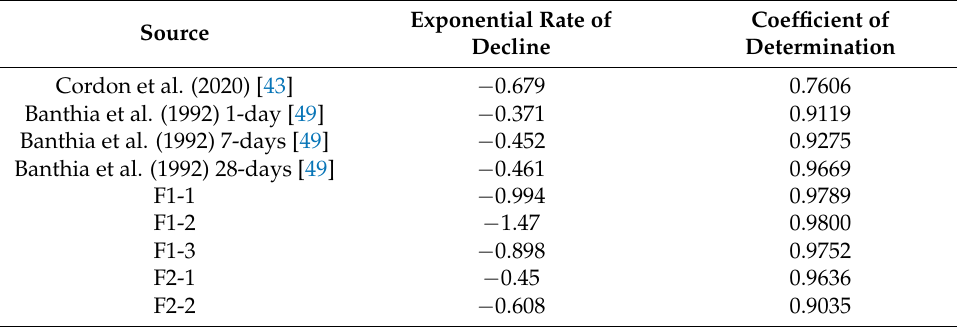
Figure 11. The residuals plot of surface electrical resistance ( Ω · m) for the proposed fit. Table 4. Formula of trends in (Figure